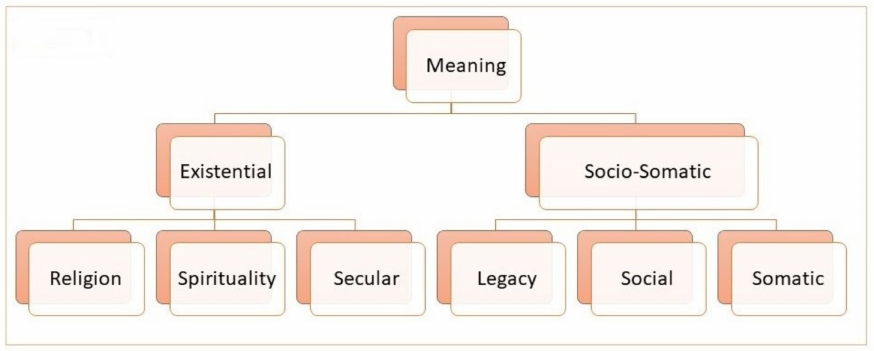
Figure 2. Inductive and taxonomic analyses.